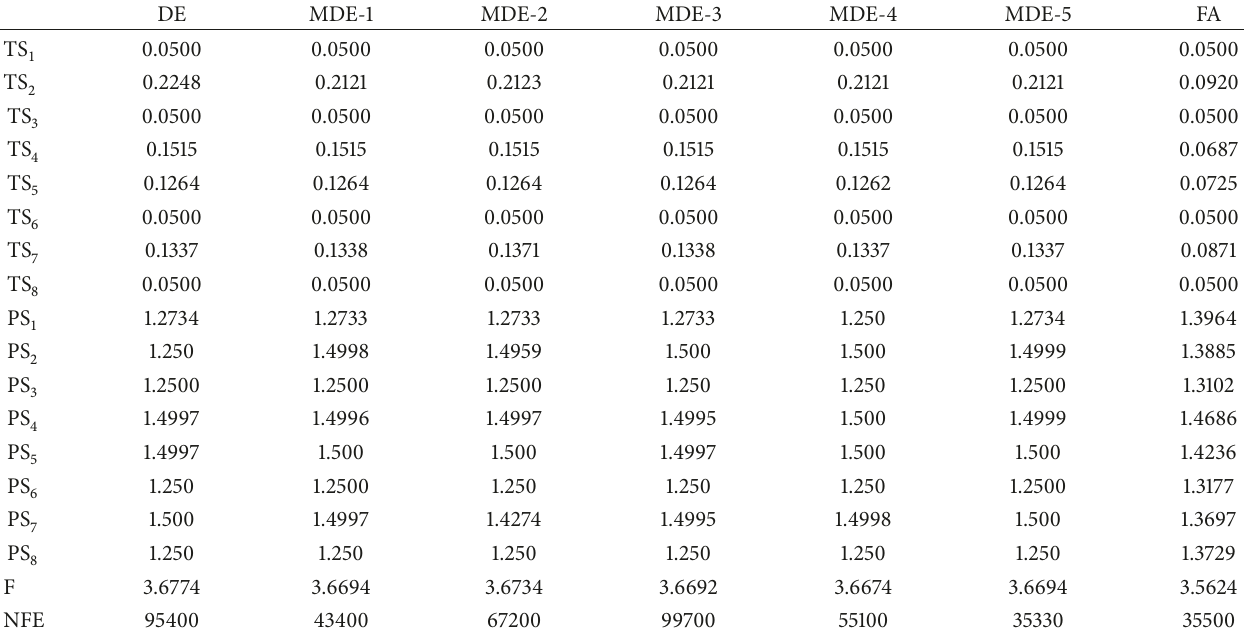
Table2:Bestdesignvariables,objectivefunctionvalues(F),andnumberoffunctionevaluations(NFE)forIEEE4-busmodelbyDE,modified DE, and firefly